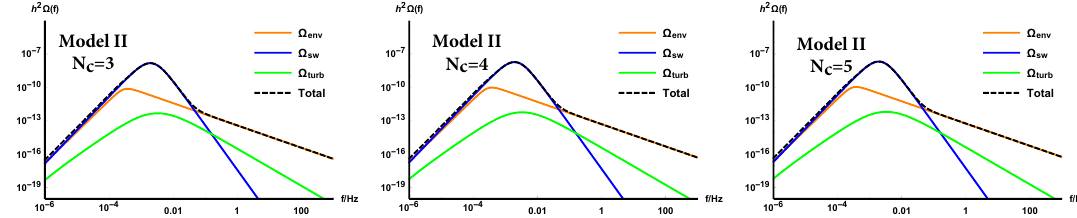
Figure 5 . The GWs spectrum or the energy density of the GWs as a function of the frequency produced from the (cid:12)rst order EW phase transition, with the parameters listed in Model II of the holographic technicolor model for N TC = 3, N TC = 4 and N TC = 5, respectively.